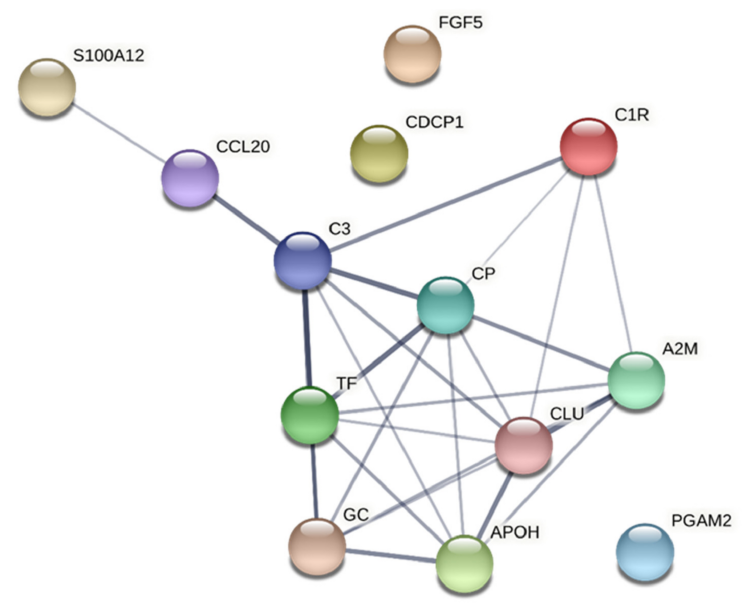
Figure 4. Network analyses of important proteins for HPT in CON. The network had the following characteristics: number of nodes: 13; number of edges: 26; average node degree: 4; avg. local clustering coefficient: 0.586; expected number of edges: 2; PPI enrichment p -value: <1.0 × 10 − 16 . Note that Ig alpha-2 chain C region and Ig kappa chain C region are not included in STRING. A2M = alpha-2-macroglobulin; APOH = beta-2-glycoprotein 1; CCL20 = chemokine (C-C motif) ligand 20; CDCP1 = CUB domain-containing protein 1; CP = ceruloplasmin; CLU = clusterin; C1R = complement C1r subcomponent; C3 = complement C3; S100A12 = protein S100-A12/EN- RAGE; FGF5 = fibroblast growth factor 5; TF = serotransferrin; PGAM2 = phosphoglycerate mutase 2; GC = vitamin D-binding protein; CON = healthy control group; HPT = heat pain